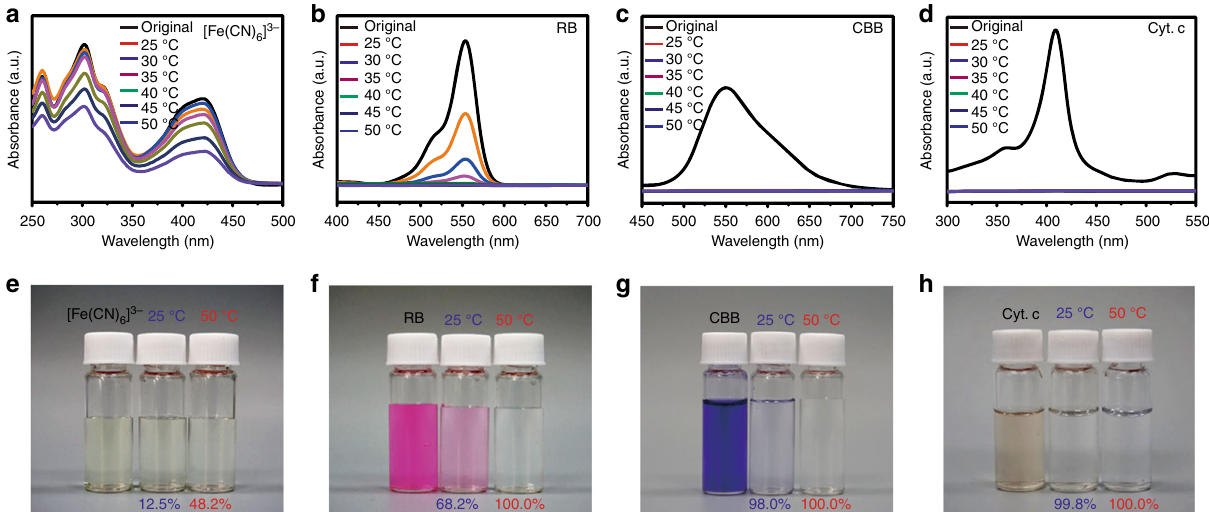
Fig. 5 P-GOMs for single molecule separation. a – d The UV-vis absorption spectra before and after fi ltering [Fe(CN) 6 ] 3 − aqueous solutions, rhodamine B (RB) aqueous solutions, coomassie brilliant blue (CBB) aqueous solutions, and cytochrome c (Cyt. c) aqueous solutions from 25 °C to 50 °C. e – h The digital photos of original solutions and the fi ltrate obtained at 25 °C and 50 °C of [Fe(CN) 6 ] 3 − , RB, CBB, and Cyt. c aqueous